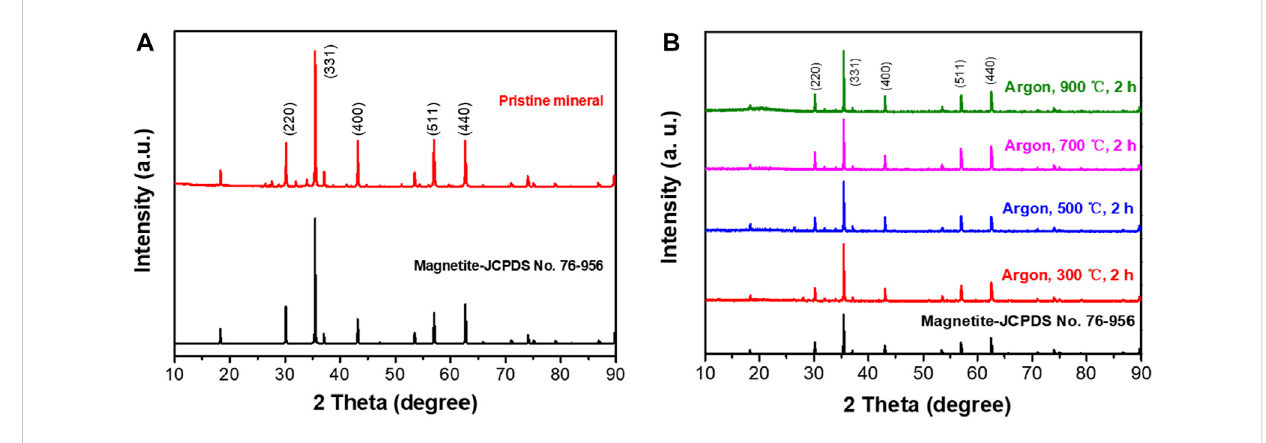
FIGURE 1 XRD patterns of magnetite ore (A) and its calcined products in argon atmosphere (B) .